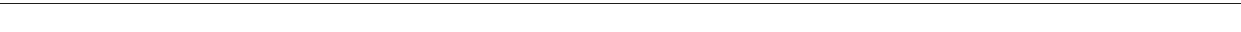
Fig. 6 Inhibition of T cell stimulated LT αβ – LT β R NIK pathway on LEC enhances T cell binding to LEC through integrin β 4 and VCAM-1. a Time-lapse, 2-D microscopy of CD4 T cell migration across LEC. LEC layers in Boyden chambers treated with 20 μ M CP or nciLT for 30 min at 37 °C, washed and naïve CD4-CFSE T cell migration to CCL19 (50 ng/mL) monitored for 3 h by live imaging. b Binding of naïve CD4 T cells to LEC pretreated with the indicated peptides (20 μ M) with or without anti-integrin mAbs (2 μ g/mL) or anti-VCAM-1 mAb (3 μ g/mL) for 30 min at 37 °C. c Binding of naïve CD4 T cells to wild type (WT) or LT β R − / − LEC pretreated with the indicated peptides (20 μ M). d LEC layers in Boyden chamber treated as in b , then naïve CD4 T cells migrated across LEC. e LEC layers treated with peptides and mAbs as in b for 30 min at 37 °C, washed, and naïve CD4 T cell migration toward CCL19 (50 ng/mL) monitored for 3 h of live imaging. f Ear whole-mount staining and migration. Pinnae injected with nciLT (5 nmol/ear) with or without anti-integrin β 4 (5 μ g) or anti-VCAM-1 mAbs (15 μ g) 30 min before transfer of naïve CSFE-labeled CD4 T cells (1 × 10 6 /ear). After 16 h, ears collected and stained for Lyve-1. Images of T cells and Lyve-1 + lymphatic vessels (left). Magni fi cation ×20; scale bar 50 μ m. Position (center) and distance (right) of T cells with respect to lymphatic vessels. g Footpad-popliteal LN migration assay. Hind footpads injected with the same doses of peptide or antibodies as in f , then 1 × 10 6 naïve CD4-CFSE T cells transferred. After 16 h, popliteal LN collected and analyzed with fl ow cytometry. h Expression of cell surface integrins on primary LEC. LEC treated with 20 μ M nciLT with or without anti-integrin β 4 mAb (2 μ g/mL) prior to co-culture with 2 × 10 5 naïve CD4-CFSE for 3 h. Unbound T cells gently washed away before fi xation. PCC Pearson ’ s correlation coef fi cient. Magni fi cation ×60; scale bar 5 μ m. i , j Immunoblot of NIK activation in LEC pretreated with the indicated peptides (20 μ M) or LT β RIg (2 μ g/mL) for 30 min, then incubated with various numbers of puri fi ed iTreg or naïve CD4 T cells ( i ) or 5 × 10 5 wild type or LT α -de fi cient iTreg ( j ) for 6 h. The bar graphs represent the relative band intensities (mean ± SEM) from three independent experiments. k Expression of LT β R and NIK in primary LEC pretreated with 20 μ M nciLT or 2 mg/mL LT β RIg for 30 min at 37 °C, and co- cultured with 2 × 10 5 iTreg-CFSE for 6 h. Magni fi cation ×60; scale bar 5 μ m. * p < 0.05 by Students ’ t- test ( a ) or by one-way ANOVA ( b – k